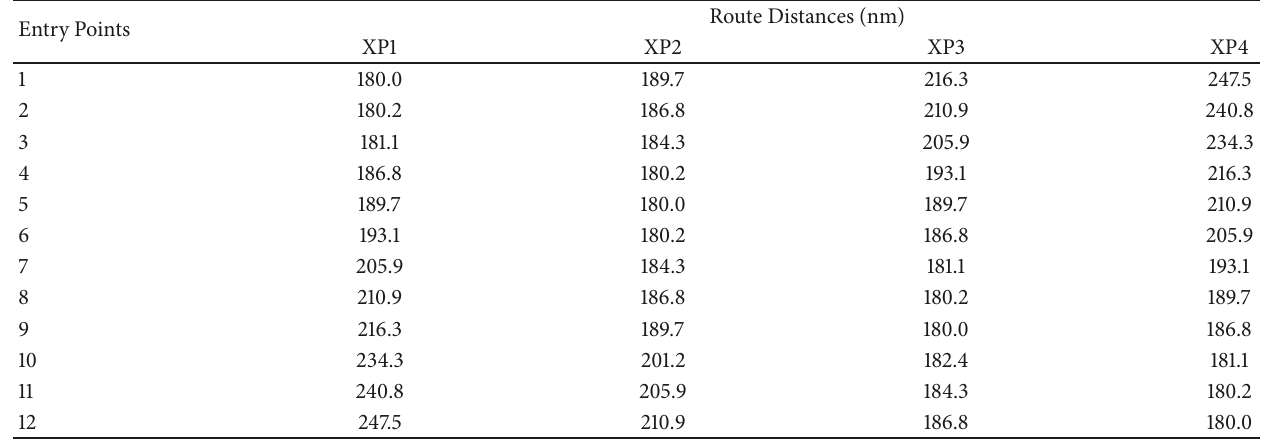
Table 8: Routes distances in complex